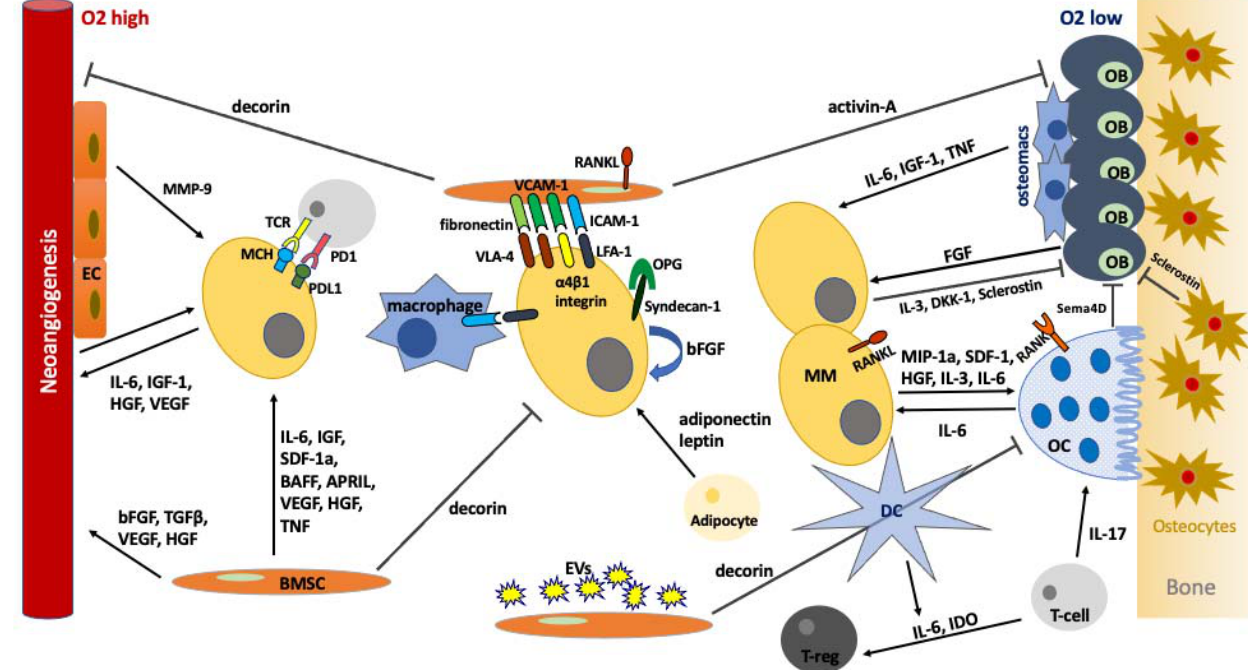
Figure 1. The complex interactions among the cellular components of the BMM in MM.